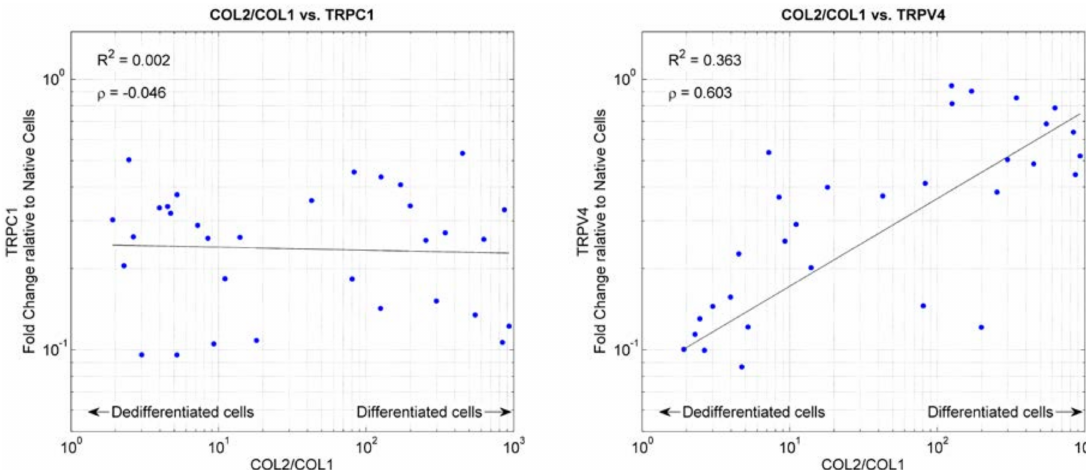
Figure 7. mRNA expression of TRPC1 ( left ) and TRPV4 ( right ) plotted against the chondrocyte dedifferentiation marker COL2 / COL1 . High values of COL2 / COL1 indicate differentiated chondrocytes, whereas low values indicate dedifferentiated cells. The mRNA expression of TRPC1 and TRPV4 was normalized to the respective gene expression of native cells. The black line indicates linear regression of the 10-base logarithm transformed data. R 2 indicates the corresponding coefficient of determination. The ρ -value indicates the Pearson’s linear correlation coefficient of the 10-base logarithm transformed